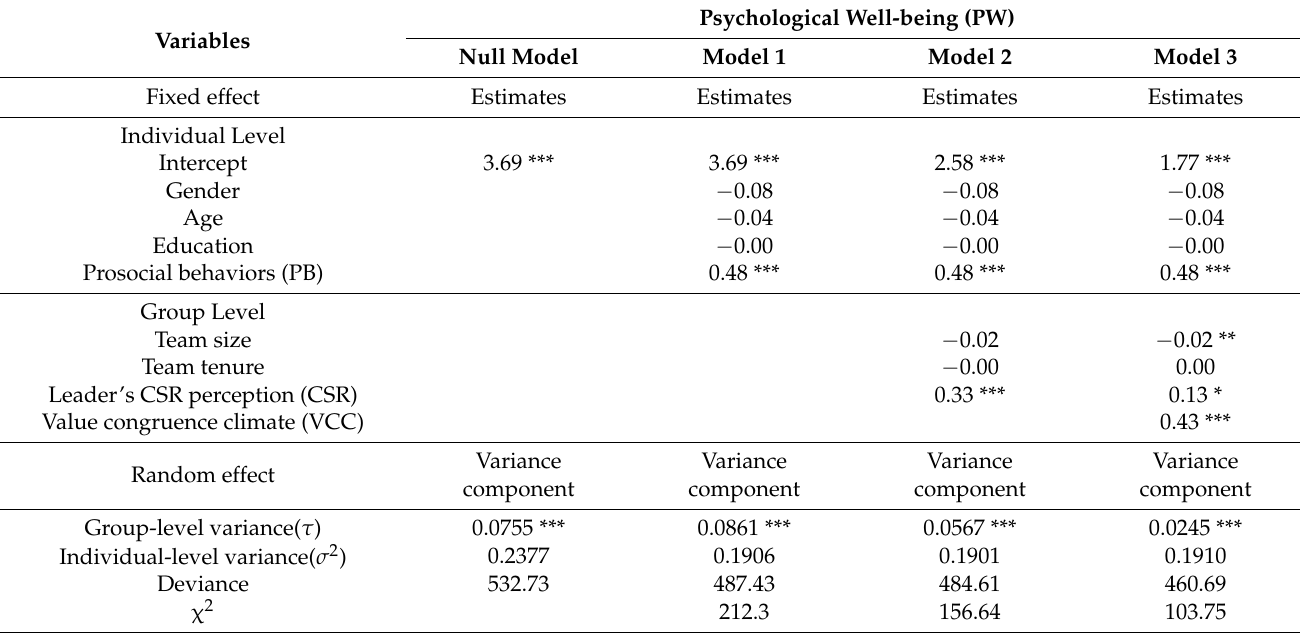
Table 3. Hierarchical linear model predicting psychological well-being (PW): Direct and mediating effects